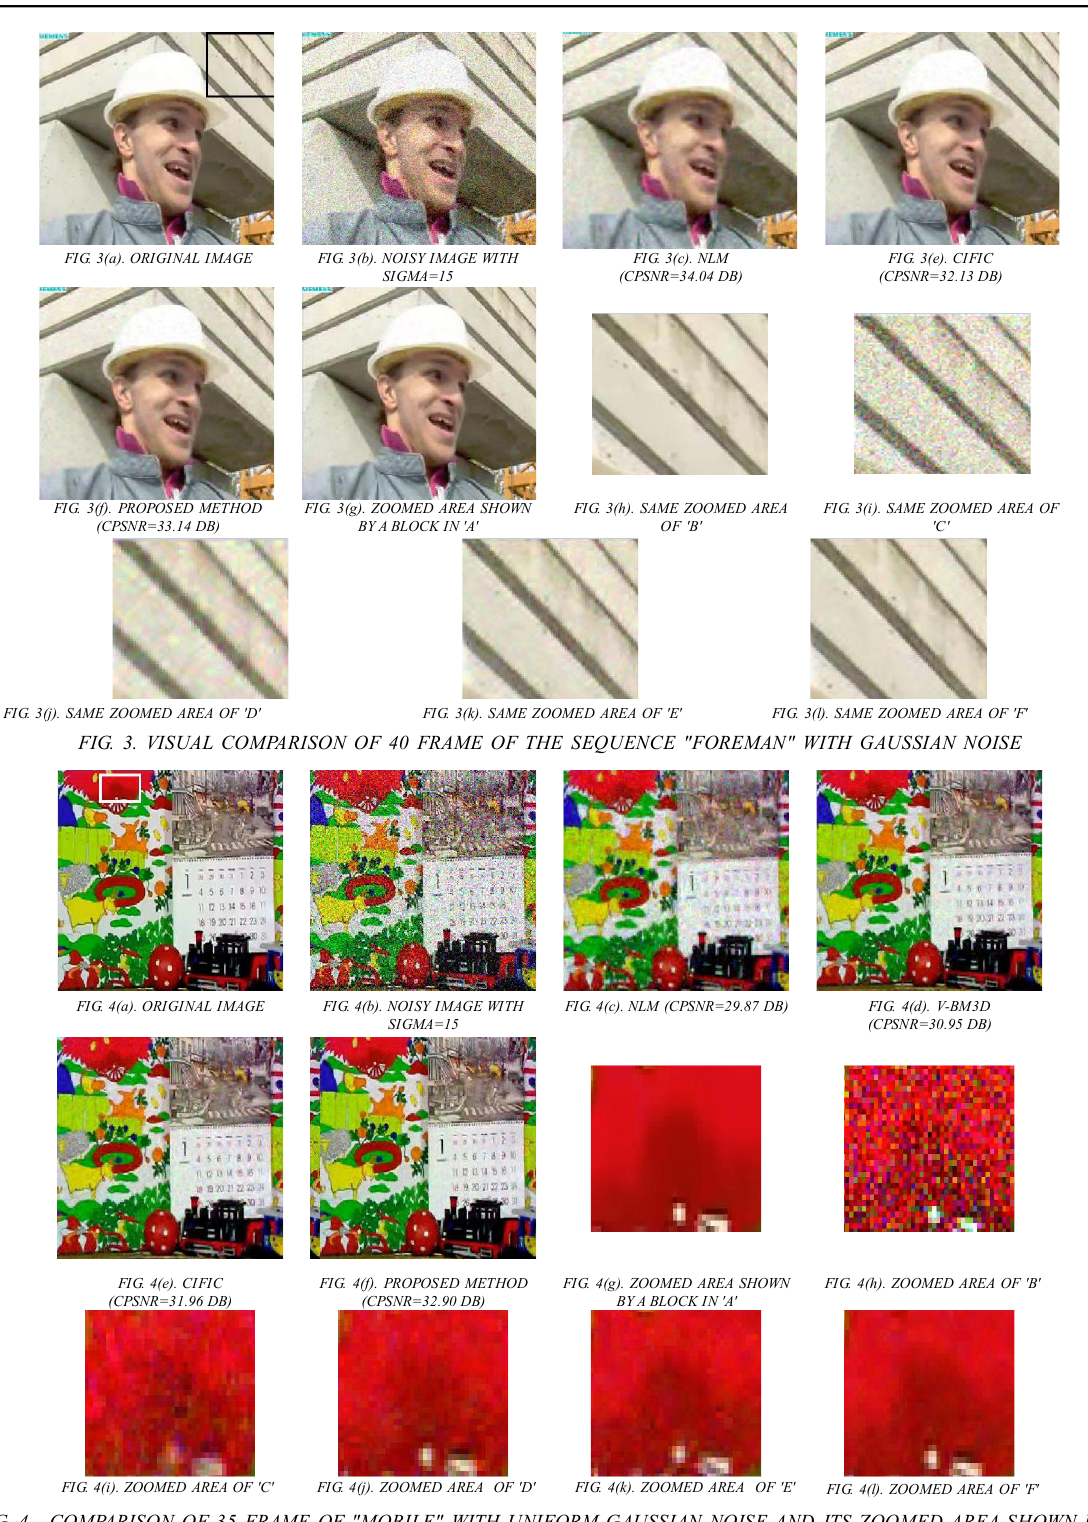
FIG. 4(i). ZOOMED AREA OF 'C' FIG. 4(j). ZOOMED AREA OF 'D' FIG. 4(k). ZOOMED AREA OF 'E' FIG. 4(l). ZOOMED AREA OF 'F' FIG. 4. COMPARISON OF 35 FRAME OF "MOBILE" WITH UNIFORM GAUSSIAN NOISE AND ITS ZOOMED AREA SHOWN BY A BLOCK IN ORIGINAL